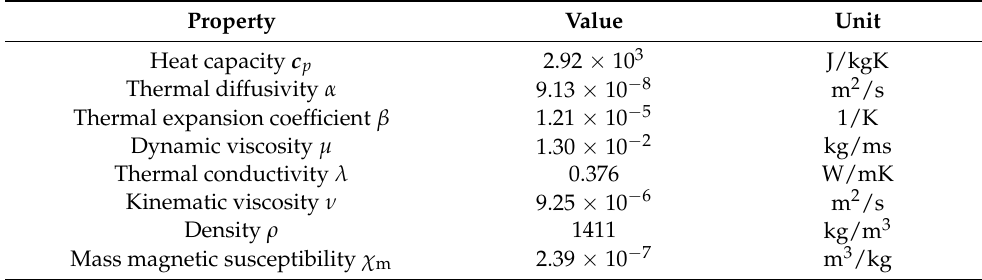
Table 1. Properties of the working